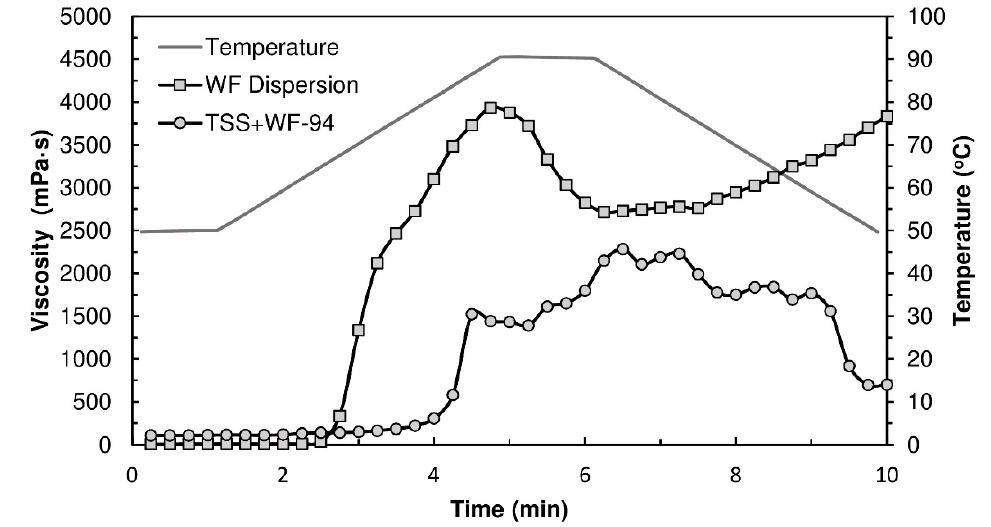
Figure 4. Viscograms of WF dispersion and TSS+WF-94 binder, determined with a rotational rheometer.